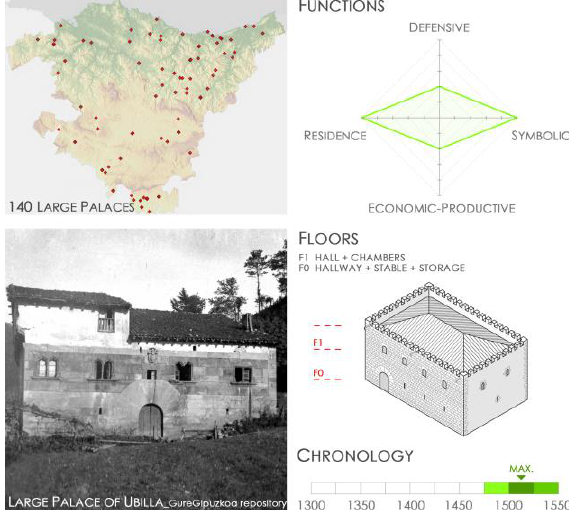
Figure 5. Large Palaces of the Basque